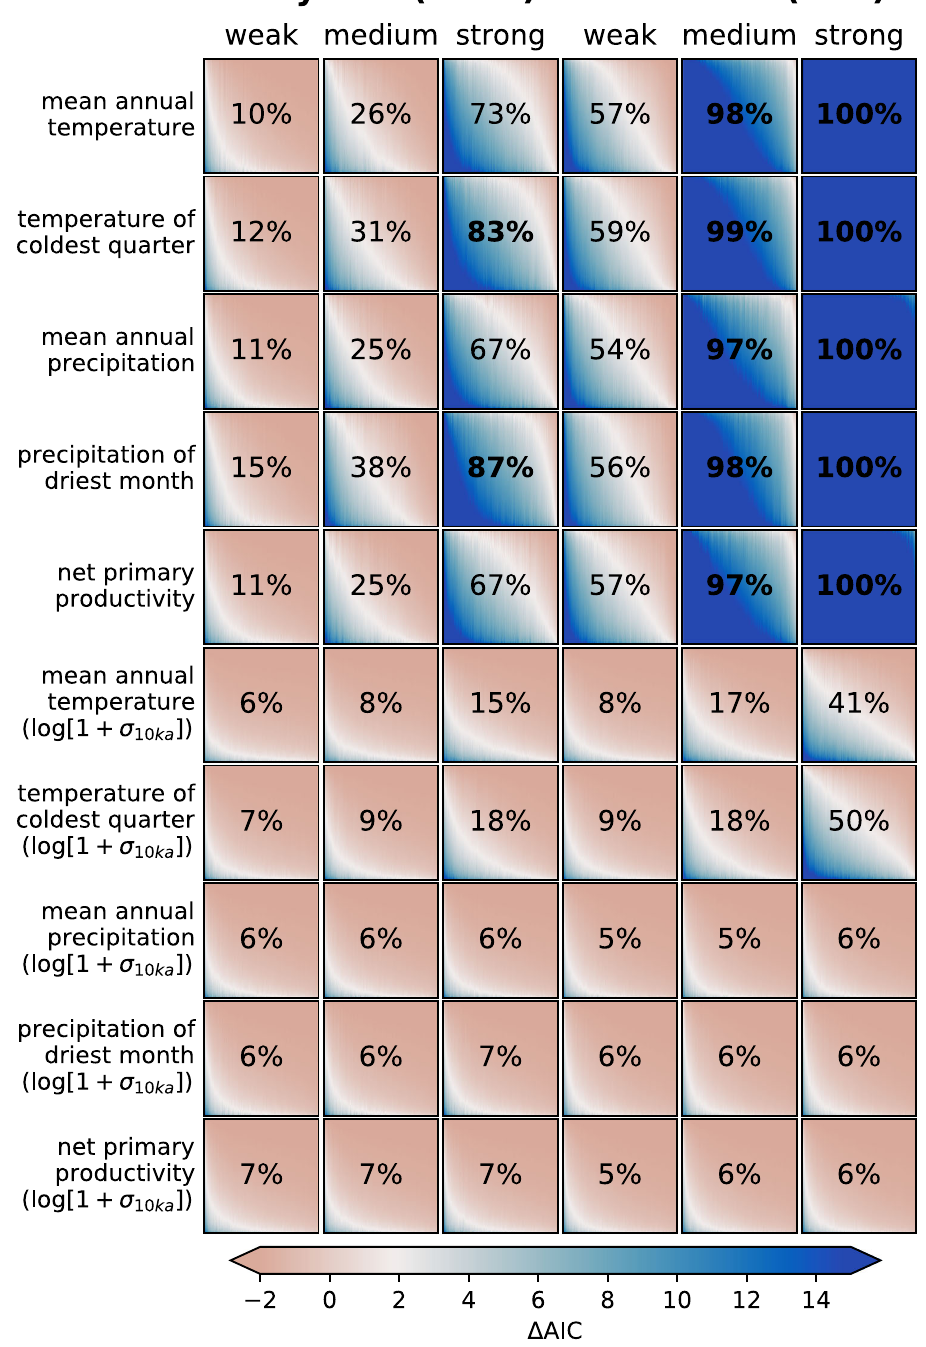
Fig. 2 Power analysis for body and brain size data with environmental variables. The power analysis shows the proportion of synthetic datasets ( n = 1000) for which a relationship using the LM-TC model is detectable, i.e., Δ AIC ≥ 2 (LM-T relative to LM-TC). The color gradient in each panel indicates how many such relationships can be detected within each single synthetic dataset, resolved as vertical bands in each panel. Body and brain size are in log- transformed units. The color bar is chosen so that white re fl ects the Δ AIC threshold of 2. Source data are provided as a Source data fi